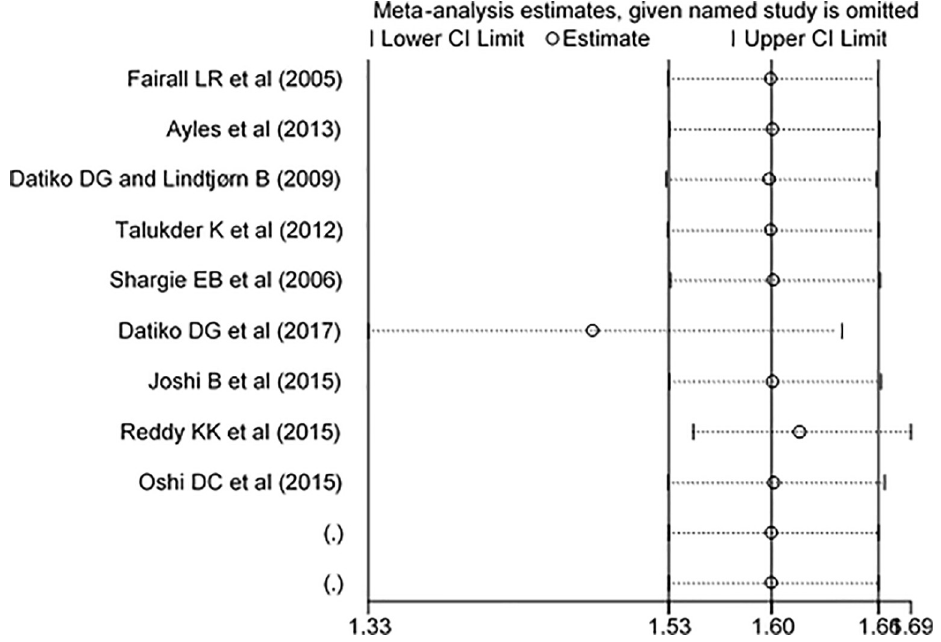
Fig 3. Sensitivity test on effect of training on tuberculosis case detection.